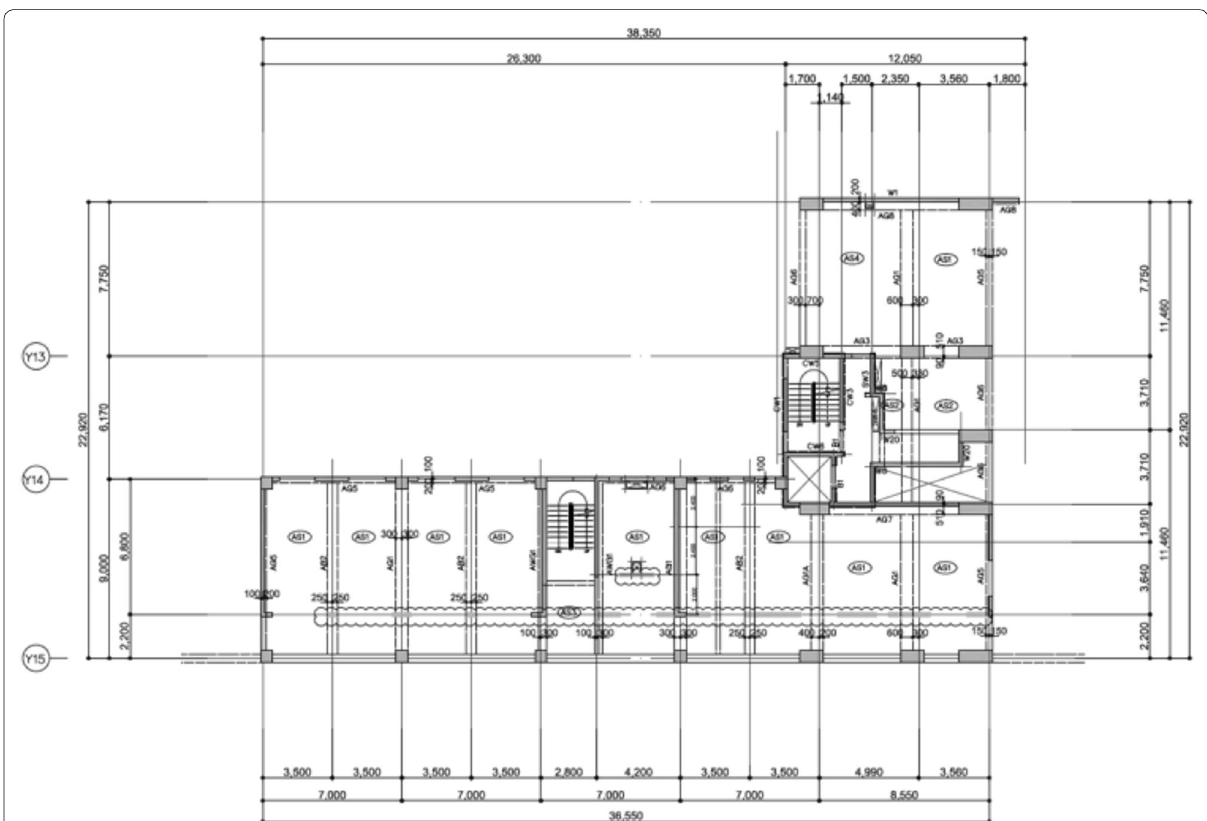
Fig. 3 Floor plan of the tested